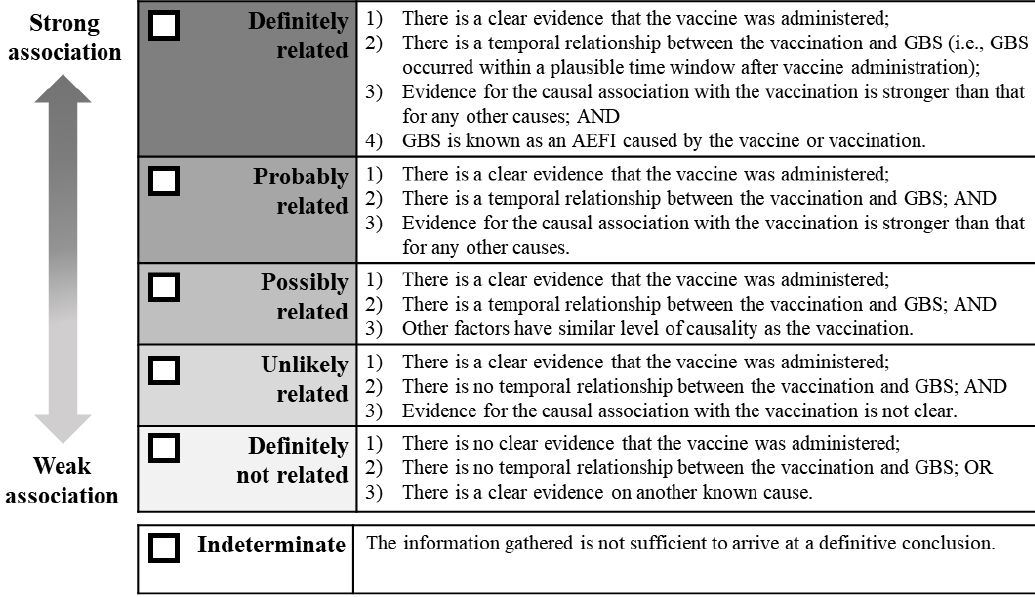
Figure 4. Causality assessment guideline for Guillain–Barré syndrome following immunization: classification of the extent of the causal association.